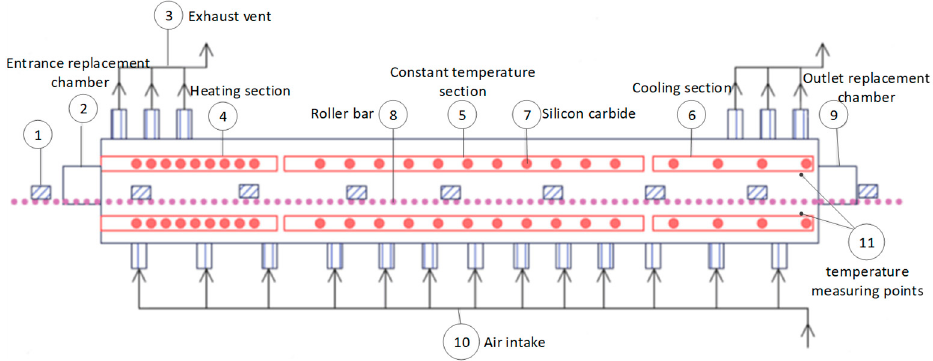
Figure 1. Sectional view of a roller kiln.